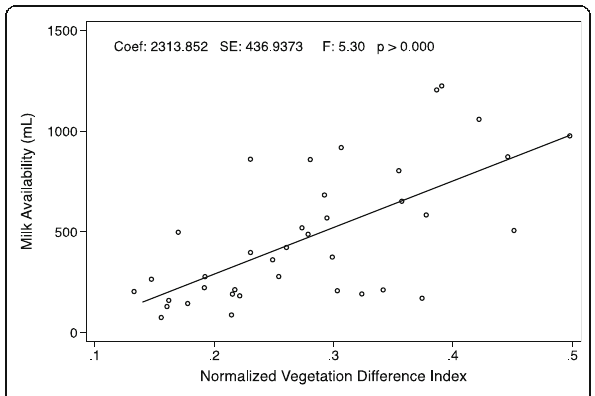
Figure 17 Regression plot of the relationship between milk availability and NDVI for all group ranches, combined